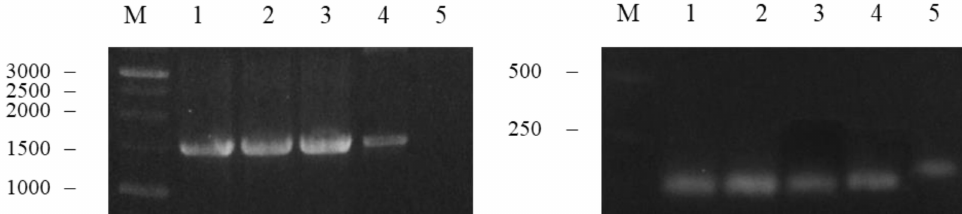
Figure 2. Amplification of the NP ( left ) and M2e ( right ) genes in a gradient PCR. Lanes M, 1 kb DNA markers; 1, 55 ◦ C; 2, 58.9 ◦ C; 3, 62.5 ◦ C; 4, 67.2 ◦ C and 5, 71 ◦ C. The amplification yield of the NP gene (~1.5 kb) decreased with the increasing annealing temperatures whereas the M2e gene (132 bp) was only amplified at 71 ◦ C.